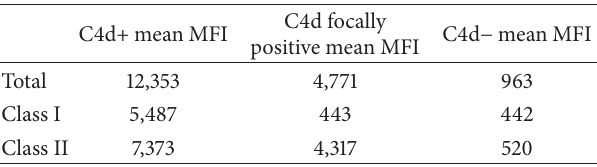
Table 5: Reactivity of monoclonal IgG subclass detection antibodies against control